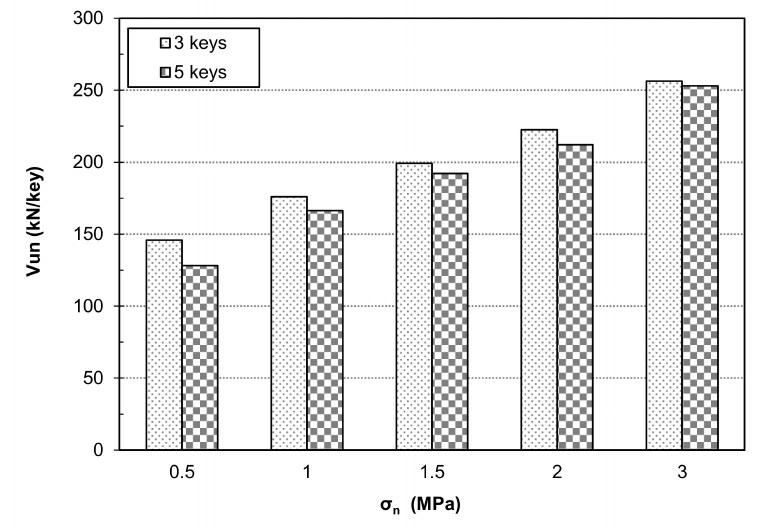
Figure 5. E ff ect of the number of keys on unitary shear capacity (V n / N k ) for V f = 0.0% and di ff erent prestress